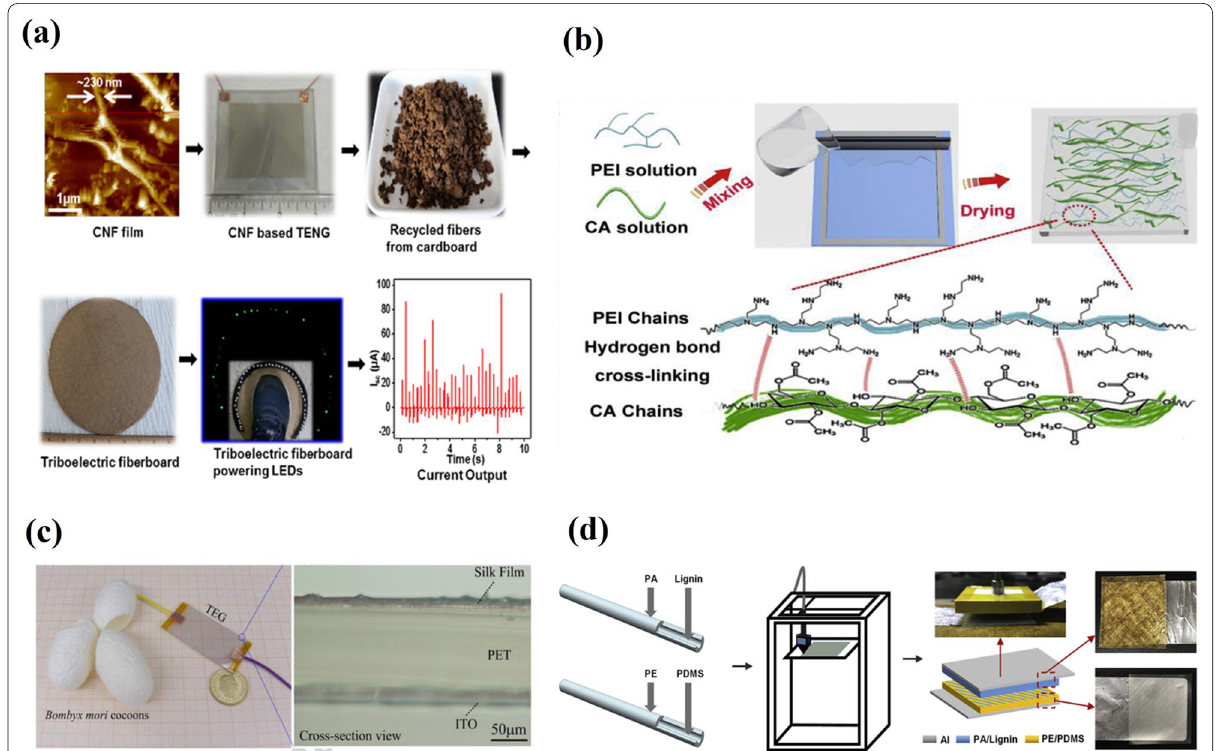
Fig. 4 Fabrication of TENGs from eco-friendly materials: a CNF-based TENG. (Reproduced with permission from Ref. [37]); b a schematic of the fabrication process for CP biocomposite and interactions between the CA and PEI molecular chains. (Reproduced with permission from Ref. [38]); c a photo of the silk-based TENG and cross-section microscope image of its bottom layer. (Reproduced with permission from Ref. [39]); d the process for preparing IBTENG and the photos of friction layers and fabricated IBTENG. (Reproduced with permission from Ref.